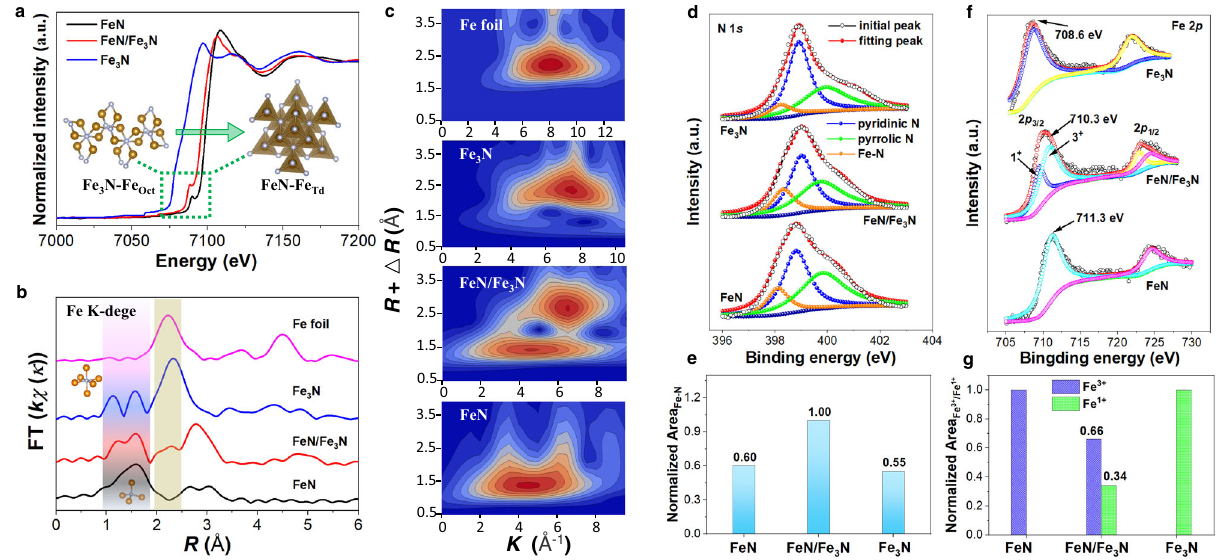
Fig. 2 | Fe-N NP coordination and electron structure characterization. a The normalized Fe K-edge EXAFS spectra. Inset: the local FeN structure showing tet- rahedral coordination (right) and Fe 3 N structure showing octahedral coordination (left). b FeK-edgeFT-EXAFSinRspaceand c wavelettransformsforthek 3 -weighted